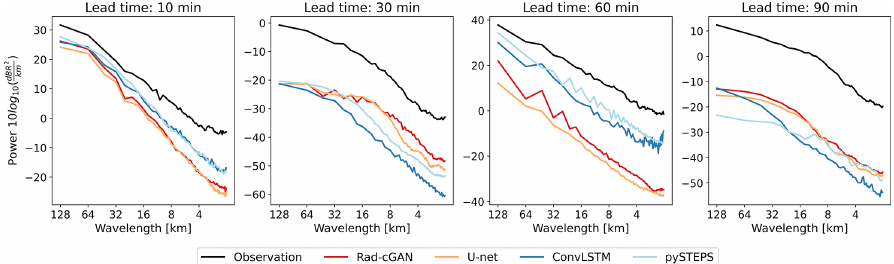
Figure 6. Radially averaged power spectral density at forecasting time t = 23 August 2018, 17:50UTC, for model predictions and observa-